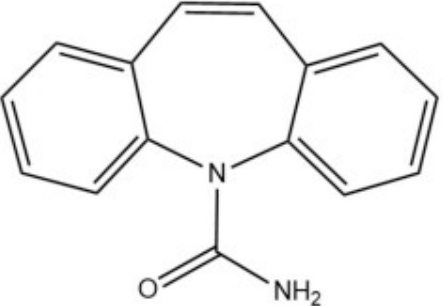
Figure 1. The chemical structure of CBZ 10,11-epoxide (CBZ-E). CYP3A4 and CYP3A5 are closely related in both structure and function [21].